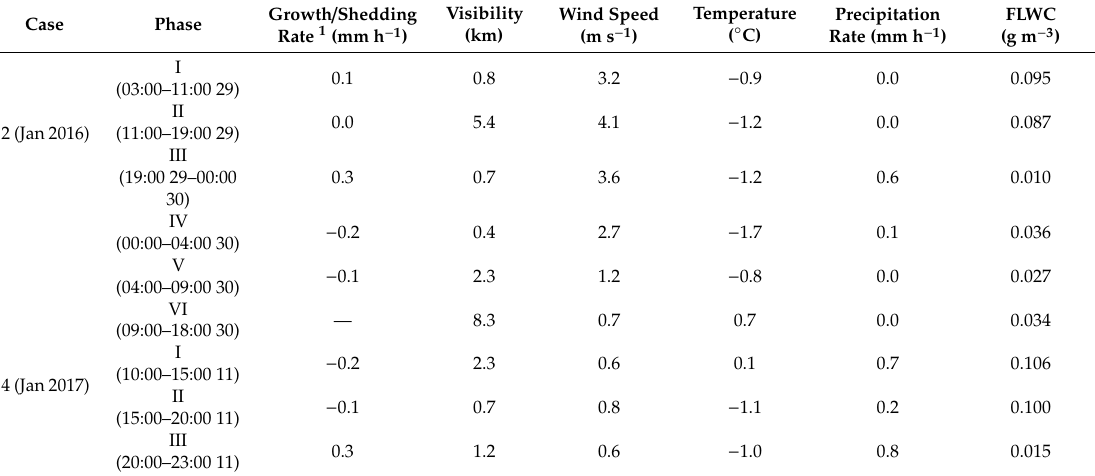
1 Positive and negative values indicate the growth and shedding rates,